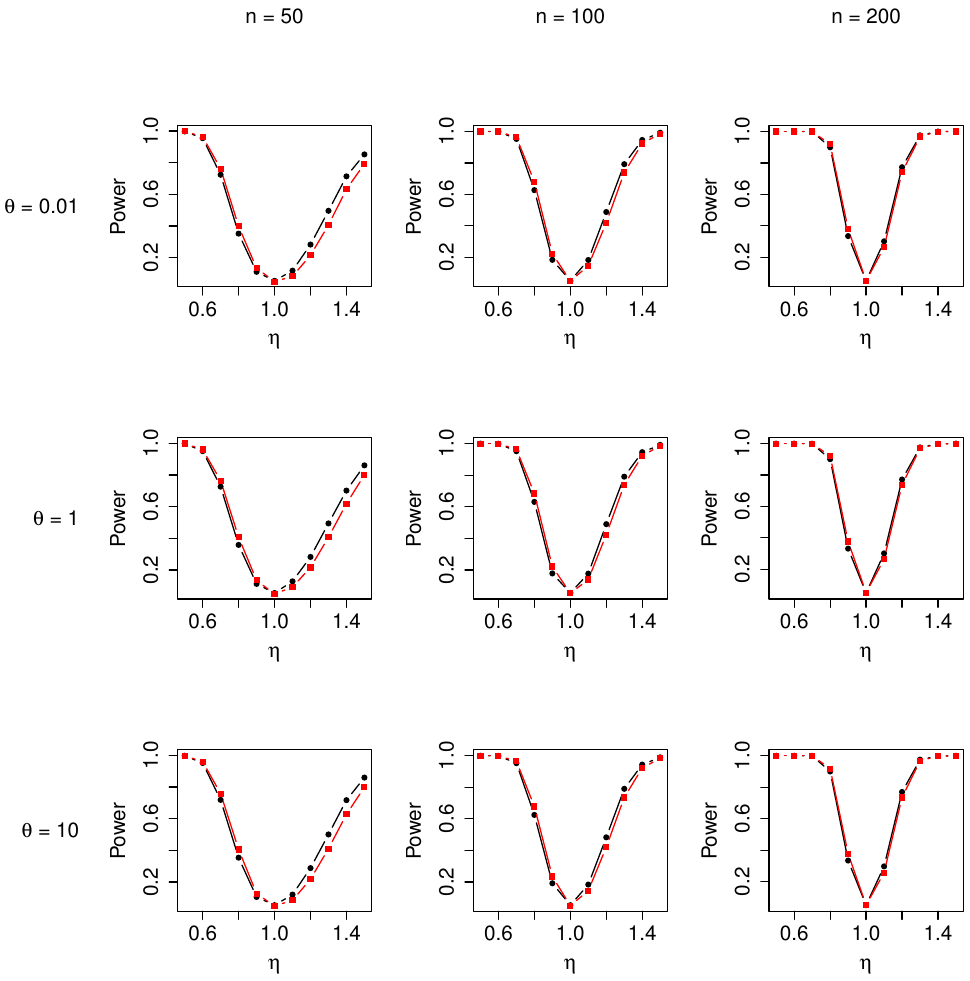
Figure 6. Power comparison of the Likelihood ratio test and asymptotic Wald’s test (the red line represents the asymptotic Wald’s test, and the black line represents the